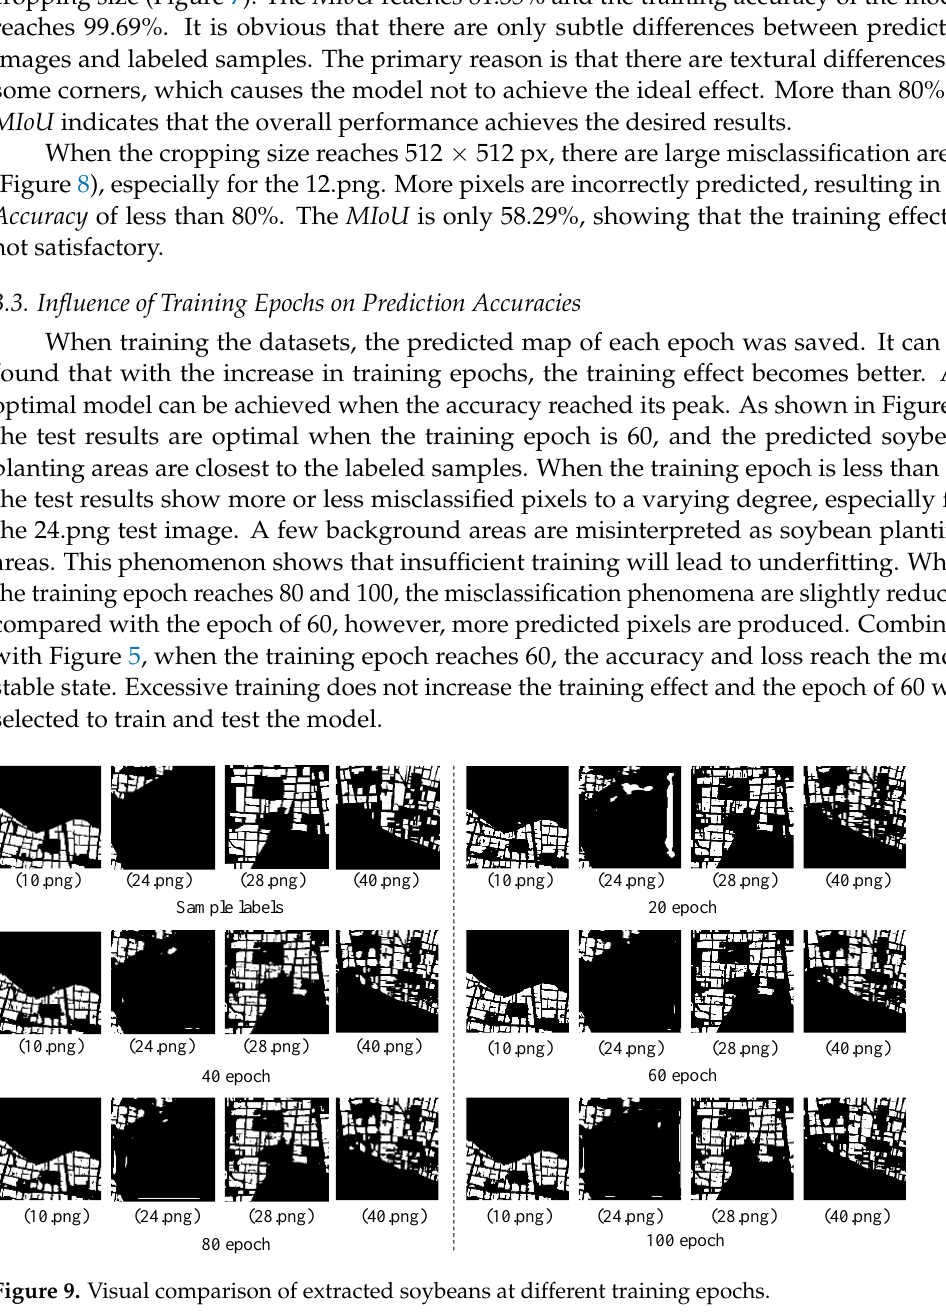
Figure 8. The test results under the 512 × 512 px cropping size.